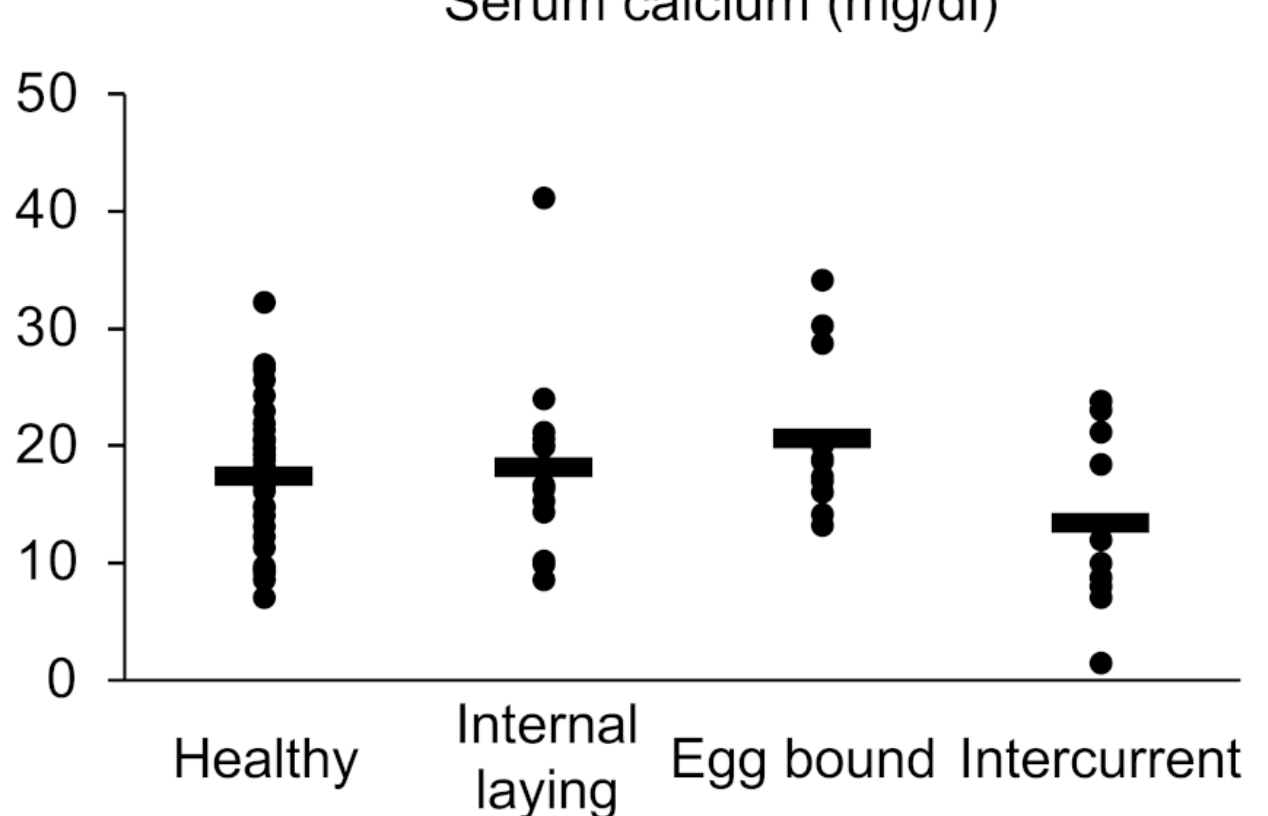
Figure 2. Serum calcium level in laying hens. There are no significant differences among groups (Tukey – Kramer test, n = 44, 14, 12, 10 for groups of healthy, internal laying, egg-bound, and intercurrent, respectively). The averages for each group are presented as the